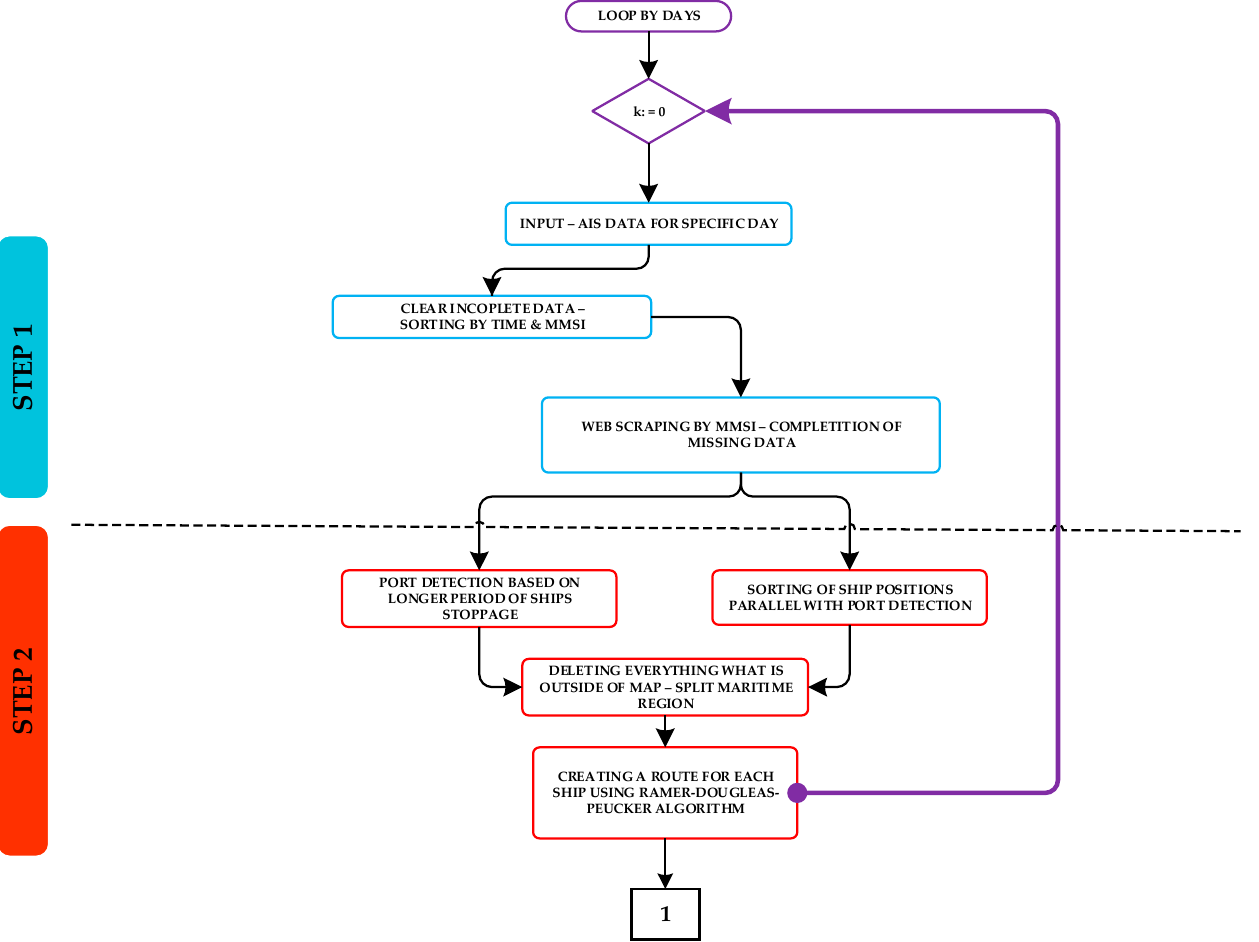
Figure 2. Flowchart for AIS data processing (Step 1) and port and ship route determination (Step 2).